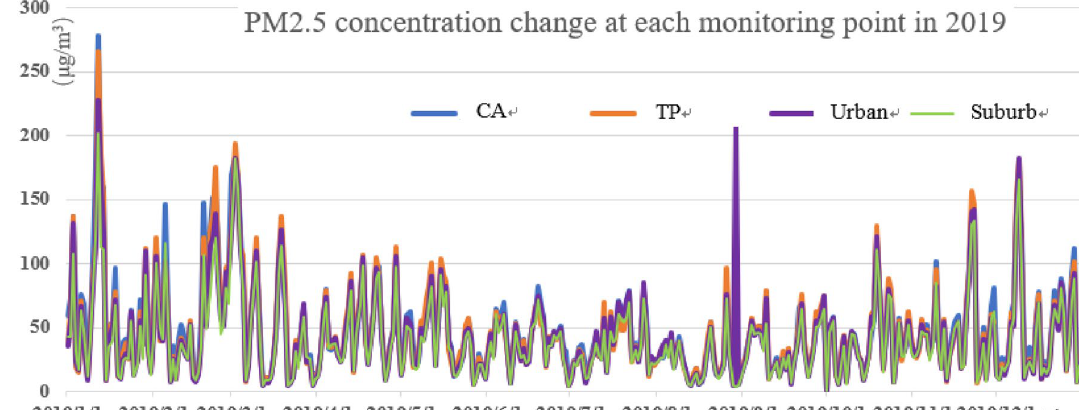
Figure 4. PM 2.5 concentration changes at each monitoring point in 2019.